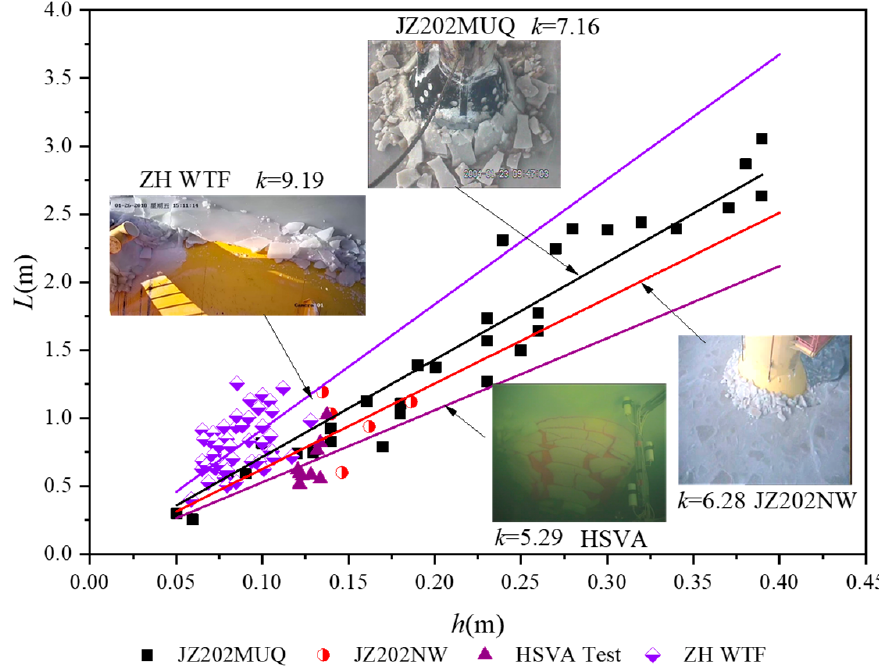
Figure 10. Length–thickness ratios, k , of sea ice bending failures at different scales. Since the cone width influences the length-to-thickness ratio coefficient obtained by fitting, Xu introduced a dimensionless parameter, the width-to-thickness ratio ( D / h ), in the analysis of ice cones (the ratio of diameter D of the cone at the sea ice to the thickness of sea ice h ) [17]; the coefficient q = D / h ; therefore, this coefficient was used to analyze the variation law of the aspect ratio. Through video data analysis, it was found that when sea ice acted on a wind-resistant anti-ice cone, when the ice thickness was less than 5 cm, the sea ice breakage length was more dispersed; multiple fractures occurred and were broken into small ice cubes, or splitting damage occurred. Therefore, the measurement data for q < 160 were selected for analysis.